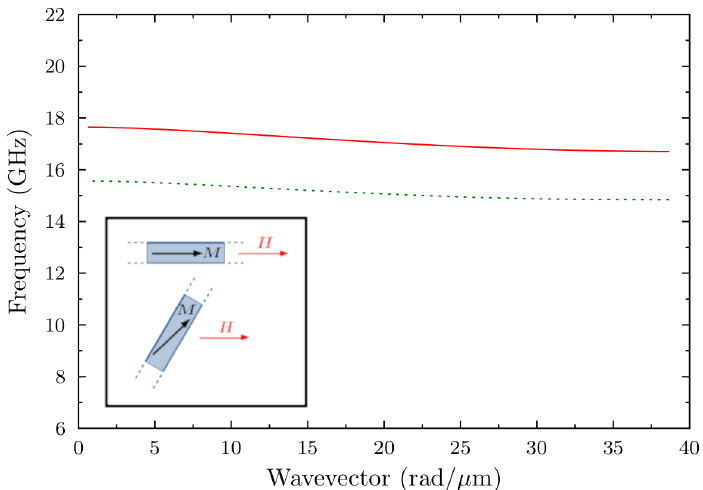
Figure 5. Dispersion curves of permalloy stripes 40 nm wide, 15 nm thick and infinite length. The frequency is plotted versus the wavevector, taken parallel to the stripe (the maximum wavevector hence corresponds to a (minimum) wavelength of 25 nm). Solid red line: the stripe is horizontal, i.e., aligned with the external field; the magnetization is assumed parallel to the stripe. Dashed green line: the stripe is tilted 60 ◦ with respect to the external field; the magnetization is uniform and rotated by 15 ◦ from the stripe axis, towards the external field. In both cases the dispersion is negative, as expected for propagation exactly, or even barely, parallel to the average magnetization. The inset shows the geometry of field and magnetization in the two